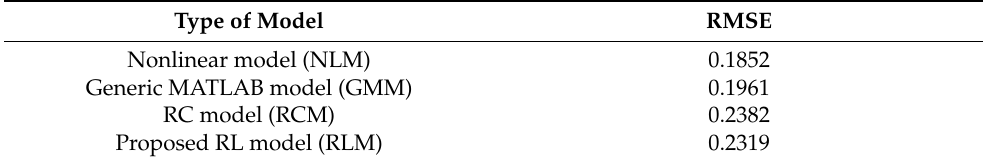
Table 4. RMSE criteria for static ( i–v ) characteristic.